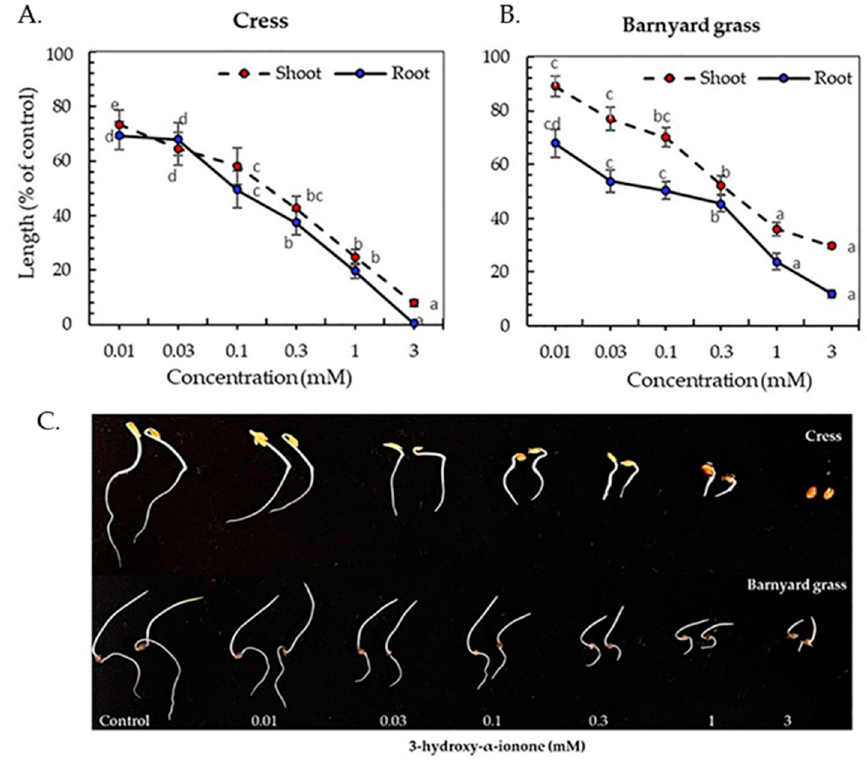
Figure 5. Effects of 3-hydroxy- α -ionone isolated from the D. volubilis extracts on the growth of ( A ) cress, ( B ) barnyard grass, and ( C ) both test plants.